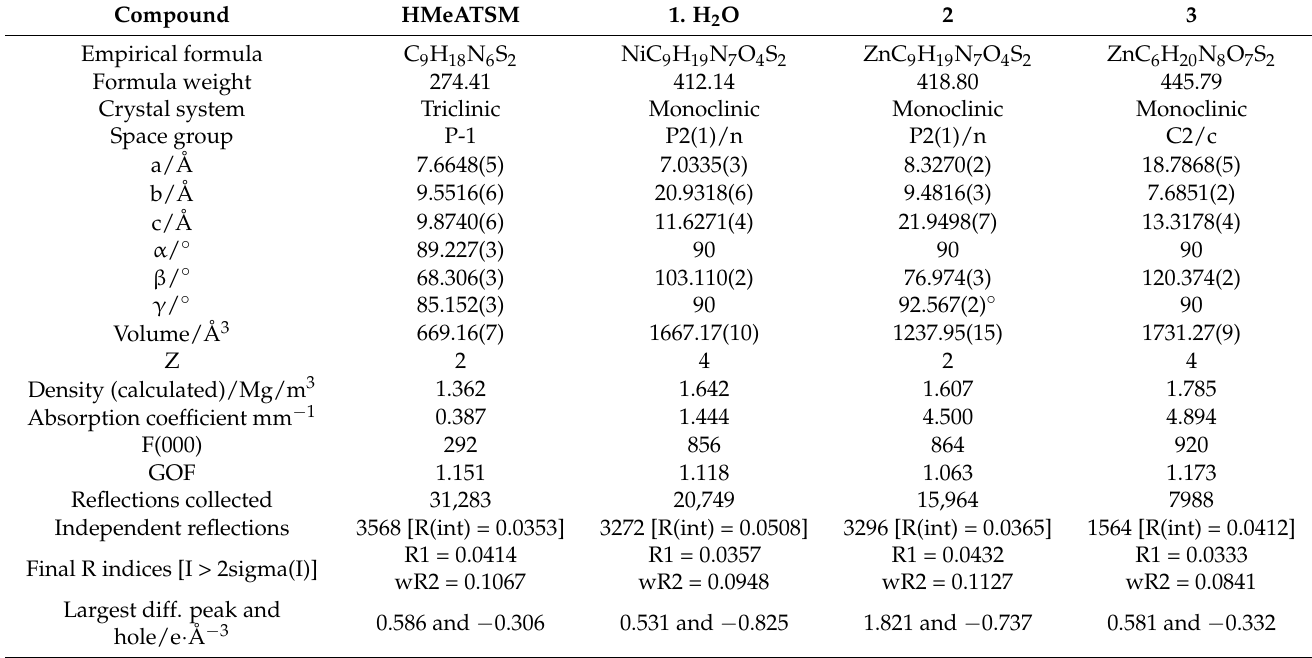
Table 1. Crystal data and structure refinements parameters for HMeATSM and complexes 1. H 2 O, 2 and 3.